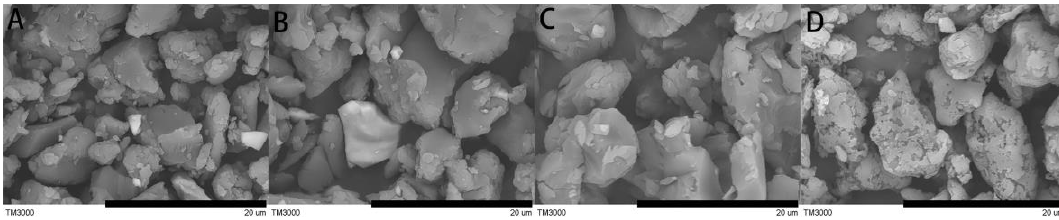
Figure 1. SEM images of samples: ( A ) poly(ionic liquid) (PIL), ( B ) PIL/polyaniline (PANI)(HCl), ( C ) PIL/PANI(NH 3 ), and ( D ) PIL/PANI(N 2 H 4 ) (Scale bar = 20 μ m).